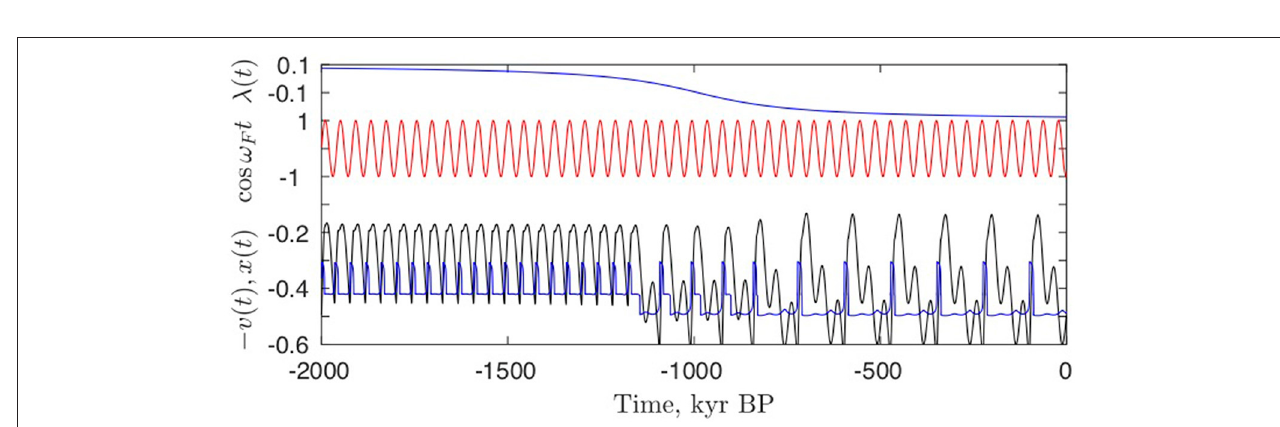
FIGURE 12 | By a slow change of the parameter λ (top blue curve) the system moves from 1:1 synchronization with the forcing through a 2:1 to a 3:1 synchronization. The system crosses the transcritical bifurcation for λ = 0 around t = − 1000 kyr. The fast (unobserved) variable x ( t ) is shown in blue. Compare with the case of the van der Pol oscillator ( Figure 8 ).